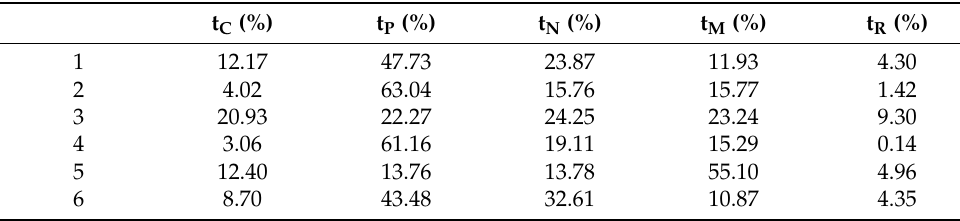
Figure 18. Execution time of AIBot. Table 2. Percentage of time spent on each